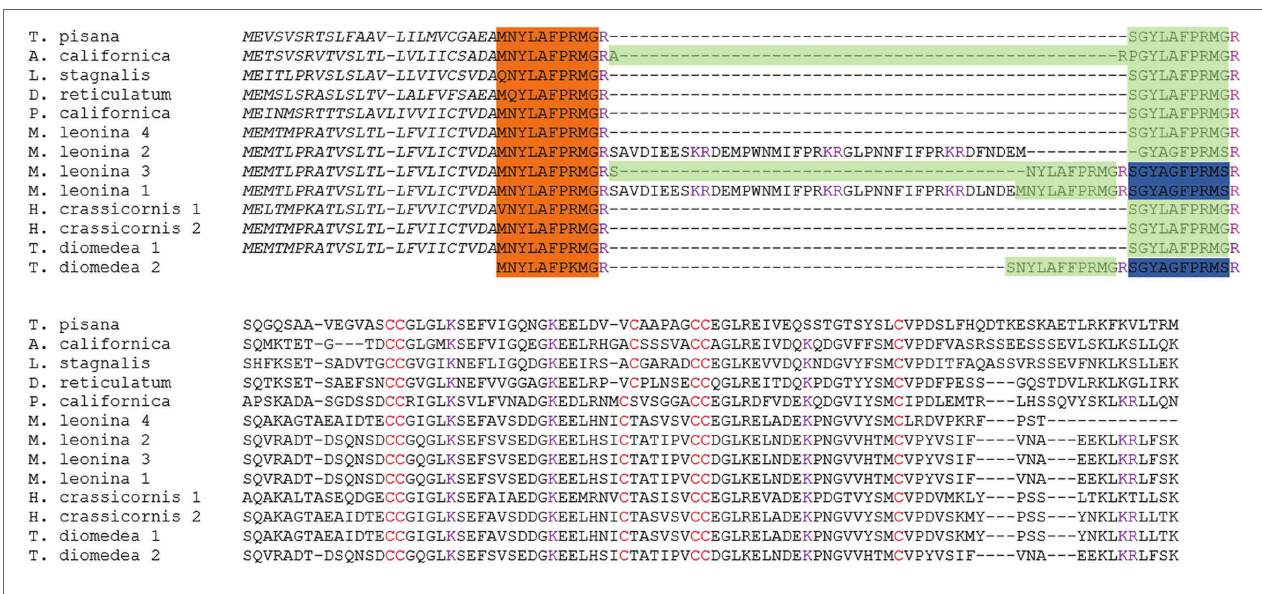
FIGURE 1 | Multiple sequence alignment of SCP prohormones across species and predicted protein isoforms. Melibe leonina yielded four SCP prohormone isoforms, and Hermissenda crassicornis and Tritonia diomedea each yielded two. Each prohormone encoded SCP B (orange highlight) and SCP A (green highlight), and one T. diomedea and two M. leonina isoforms encoded SCP C (blue highlight). Conserved cysteine (red font) and predicted or known cleavage sites (purple font) are also